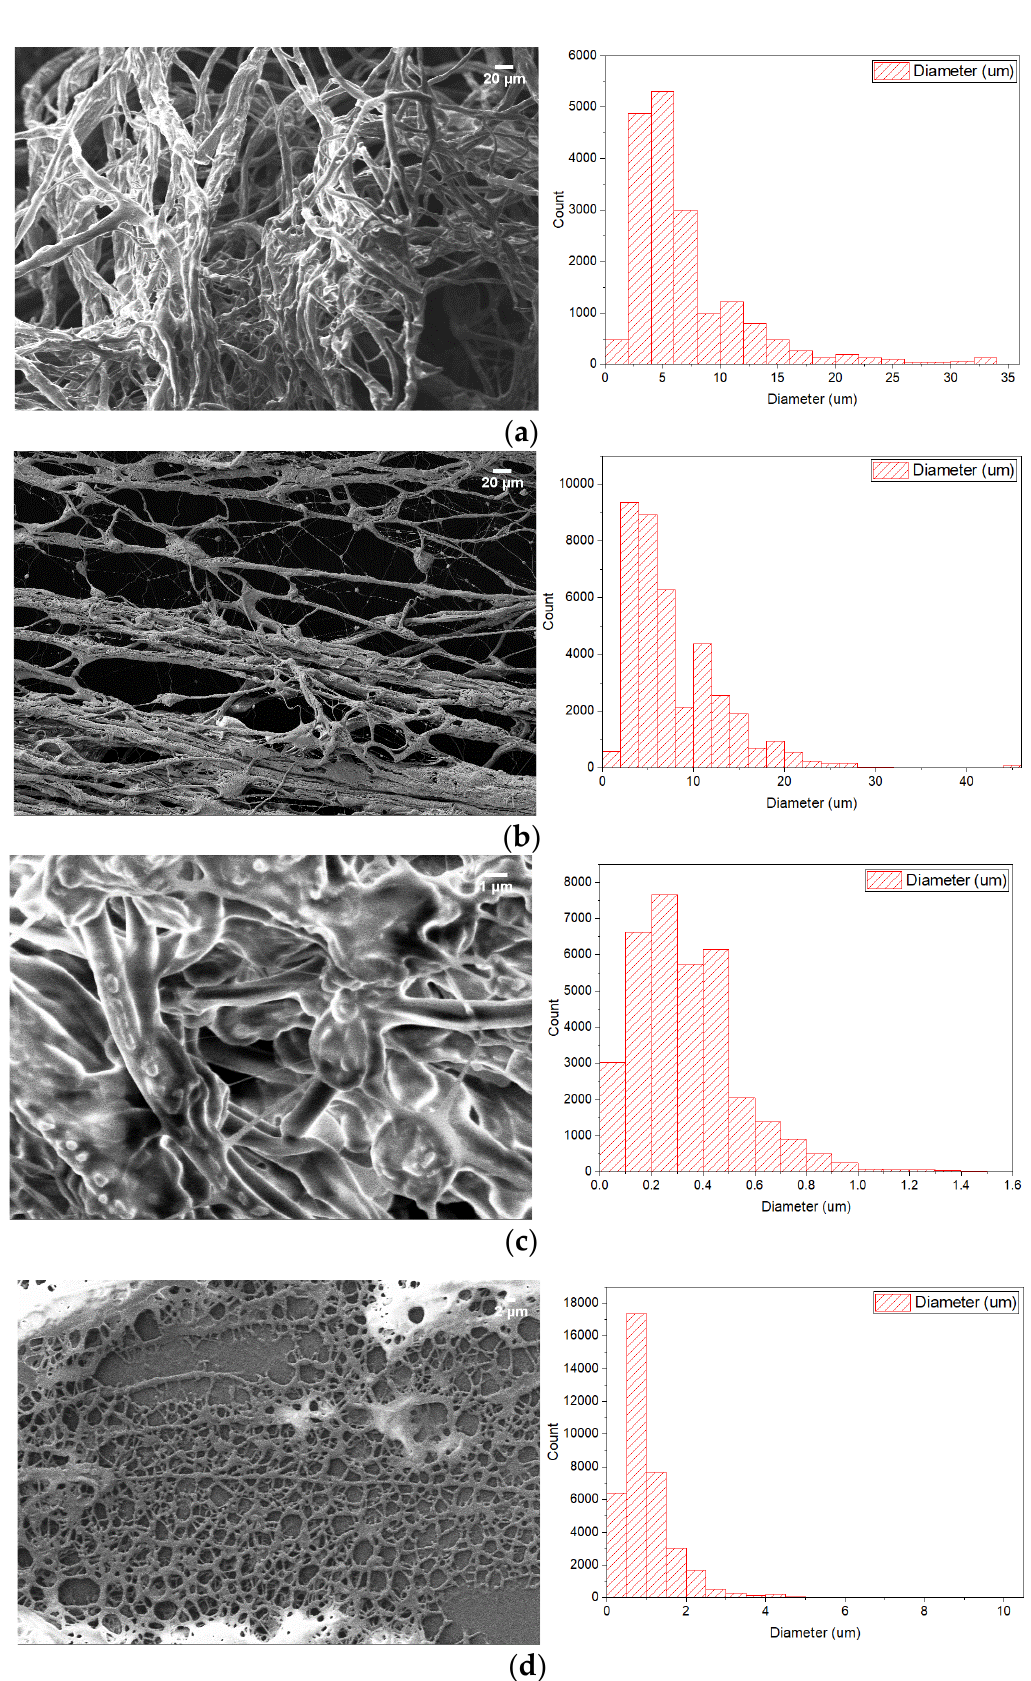
Figure 8. SEM figures of a) PT15 12%PCL 0.5-0.5ml/h, b) PT18 12%PCL 0.5-0.5ml/h, c) RT15 12%PCL 0.5-0.5ml/h, d) RT18 12%PCL 0.5-0.5ml/h